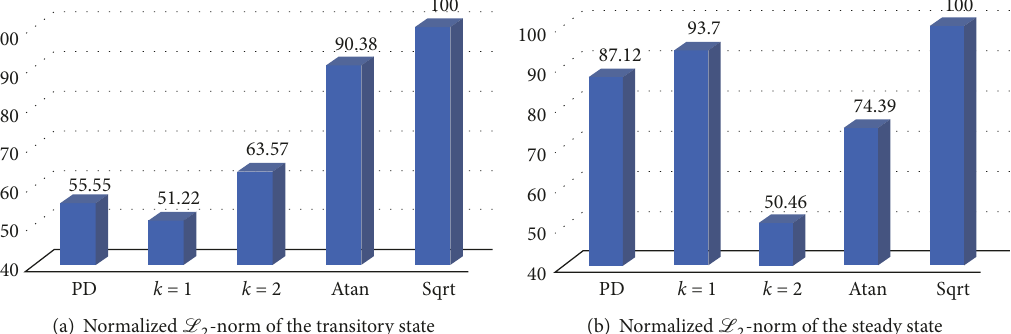
Figure 7: Performance indices L 2 of evaluated control